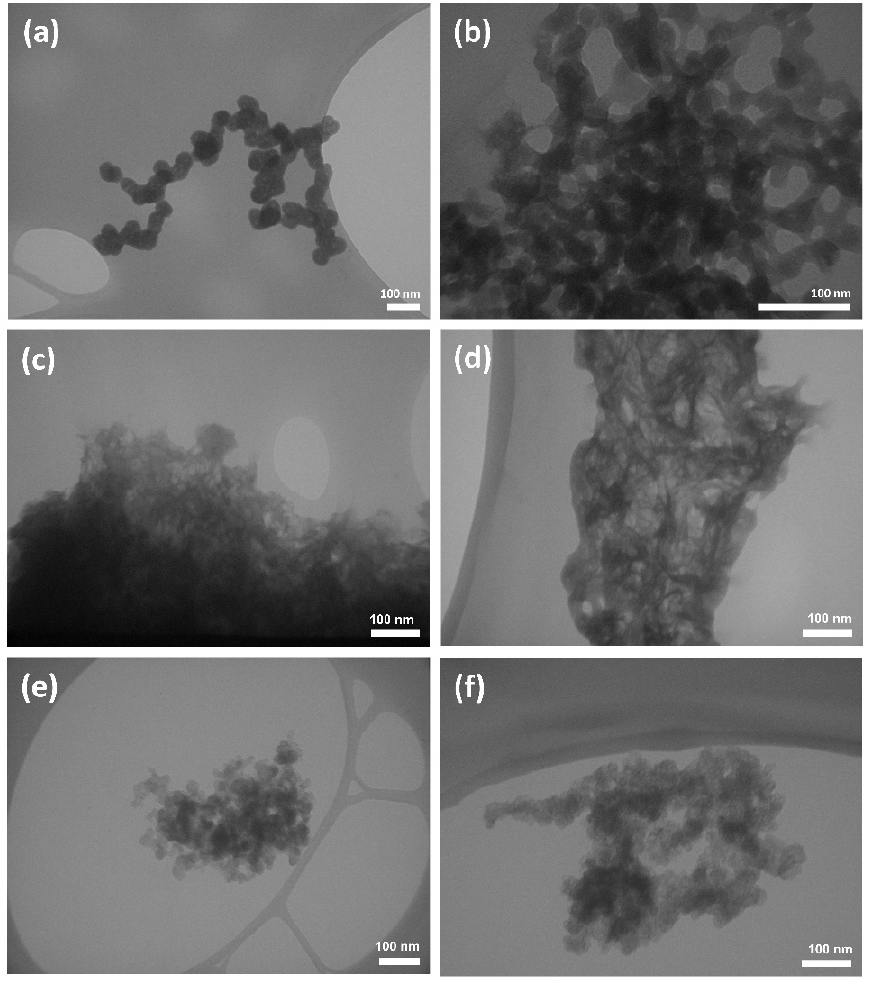
Figure 3. TEM micrographs of the precipitates formed after 10 min reaction time (60 min in case of Ser) in ( a ) control system and in the presence of 5 mmol dm − 3 ( b ) aspartic acid (Asp), ( c ) lysine (Lys), ( d ) asparagine (Asn) ( e ) serine (Ser) and ( f ) phenylalanine (Phe). c (CaCl 2 · 2H 2 O) = c (Na 2 HPO 4 ) = 5 mmol dm − 3 , c (NaCl) = 0.15 mol dm − 3 , c (AA) 5 mmol dm − 3 , pH initial = 7.4, ϑ = (25.0 ± 0.1) ◦ C, magnetic stirring.